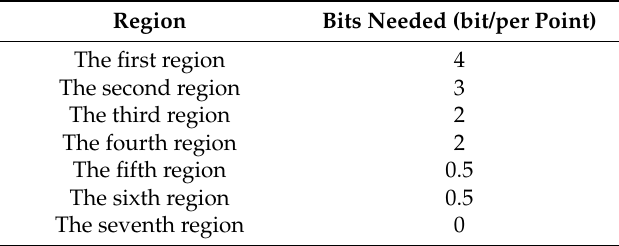
Table 3. Quantization bits for rotation matrix.